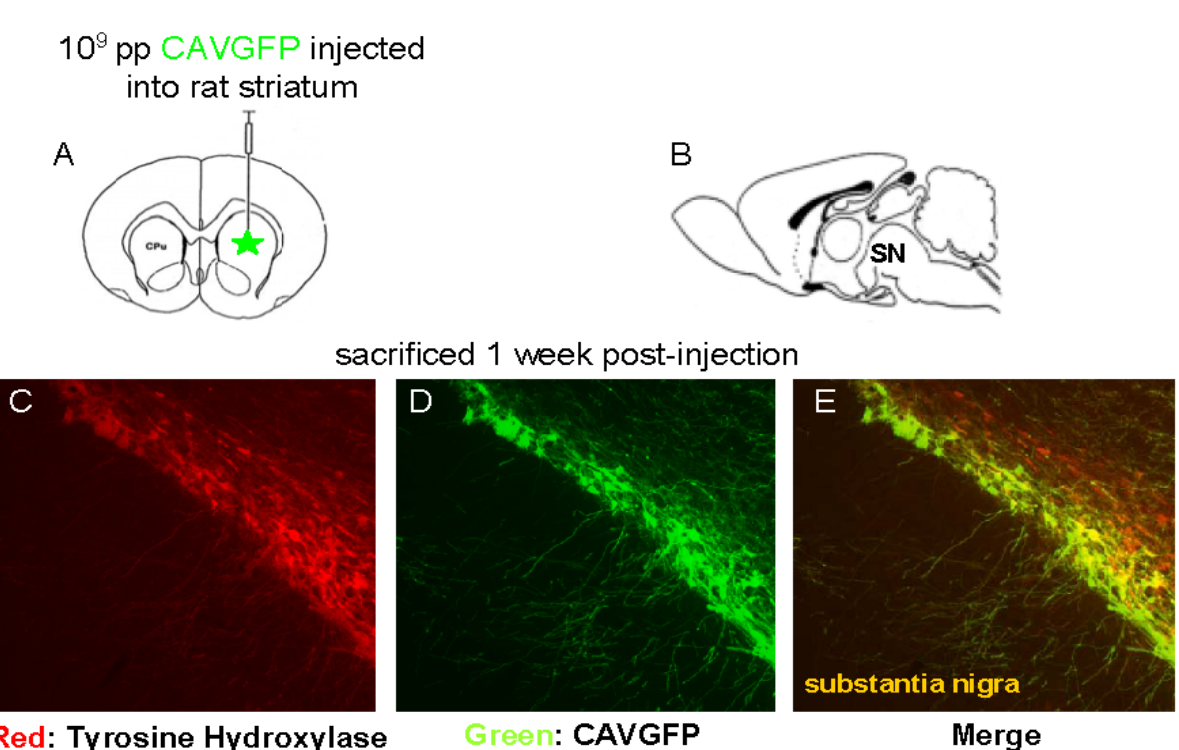
Figure 1. Stereotactic injection of a CAV-2 vector expressing GFP in the rat striatum. (A-B) Schematic inserts show respectively midsagittal and frontal cross sections of the rat brain and the location of the injection site (striatum) relative to the location of the transduced cells (substantia nigra (denoted SN )). (C) Immunolabeling for tyrosine hydroxylase (TH) expressed in the substantia nigra (red). (D) Retrograde axonal transport and expression in the vector-transduced neurons (green) in the substantia nigra. (E) Colocalization of GFP with